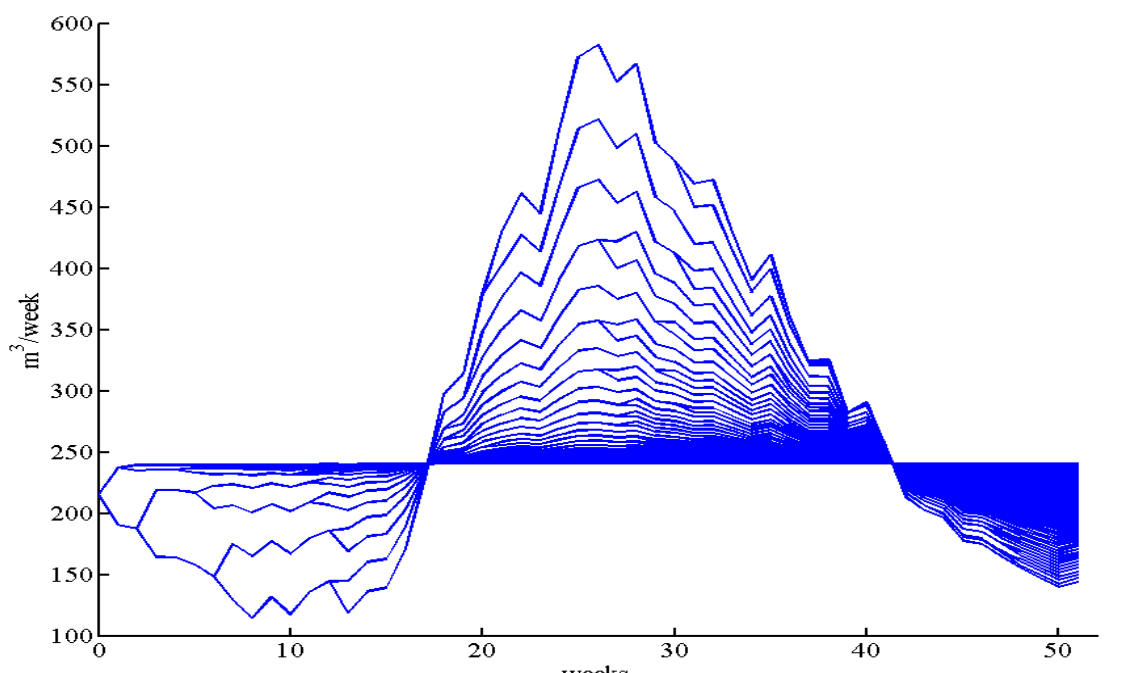
Fig. 3. Scenario tree of annual stochastic inflows to reservoir